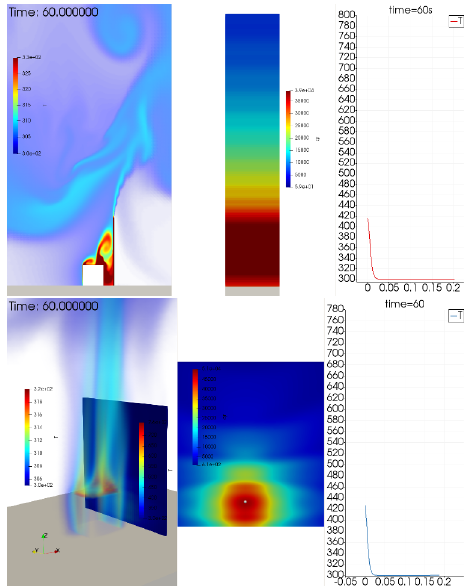
Fig. 1. Heated cube, simulation in 2D and 3D. (From left) The air temperature, the heat flux between the wall and the cube and the distribution of the temperature through the heated wall at time instance 60 s .